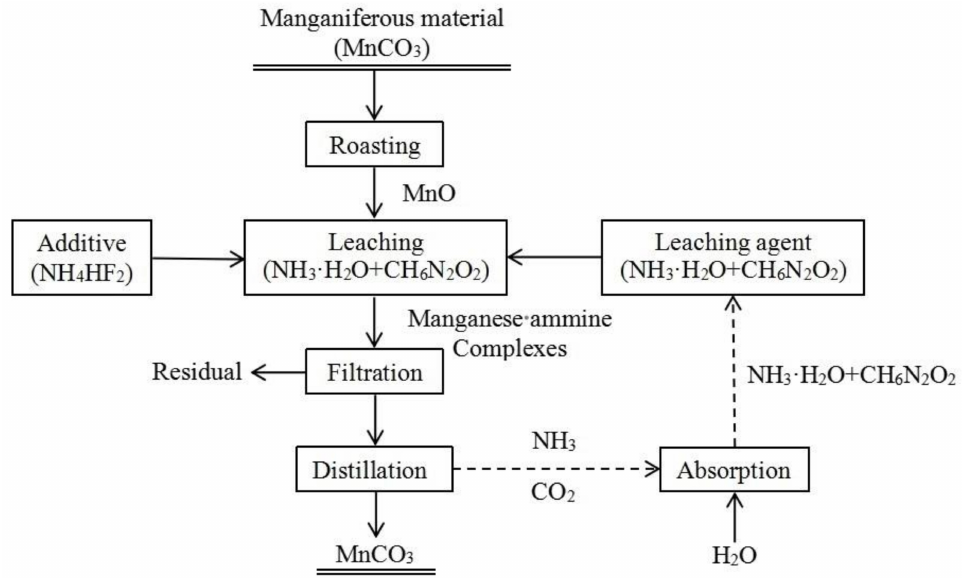
Figure 2. The technological